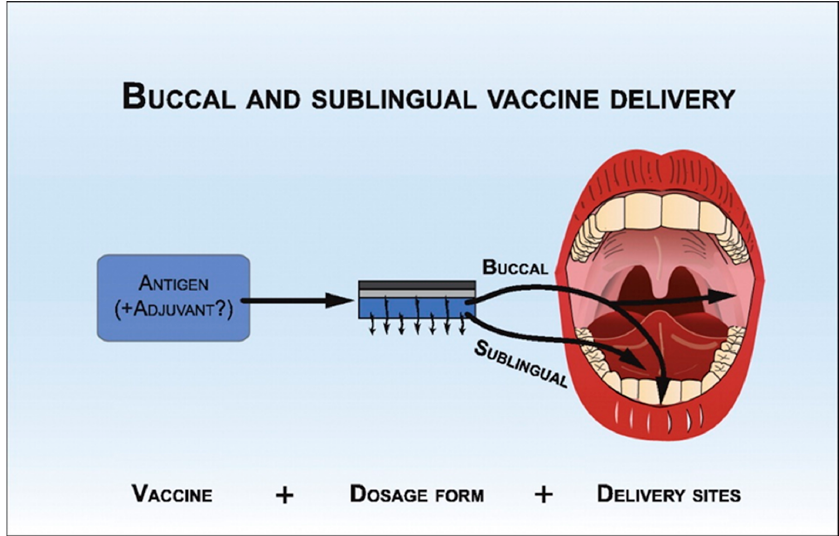
Figure 3. Graphical representation of buccal and sublingual vaccine delivery routes [23] .